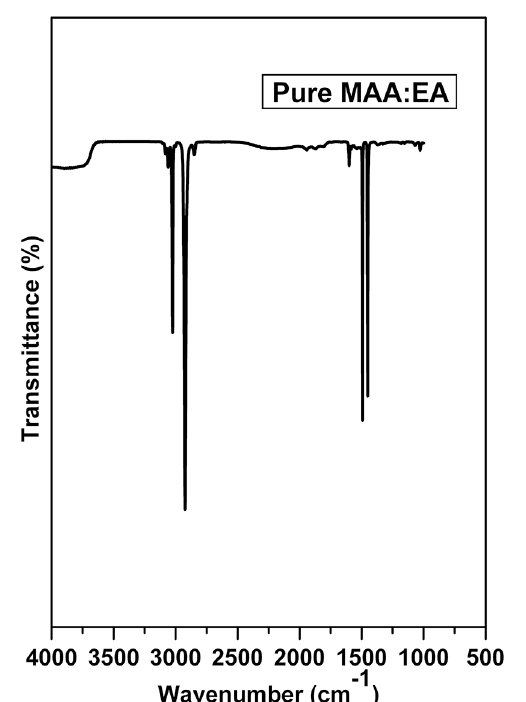
Figure 1. FTIR spectrum of pure MAA:EA